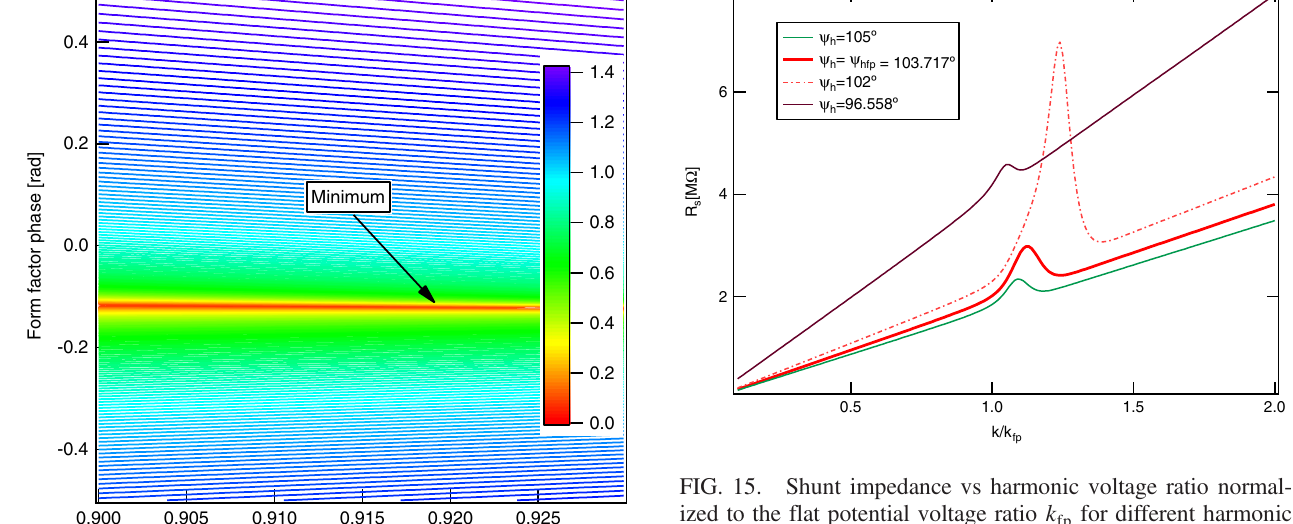
for different harmonic fp